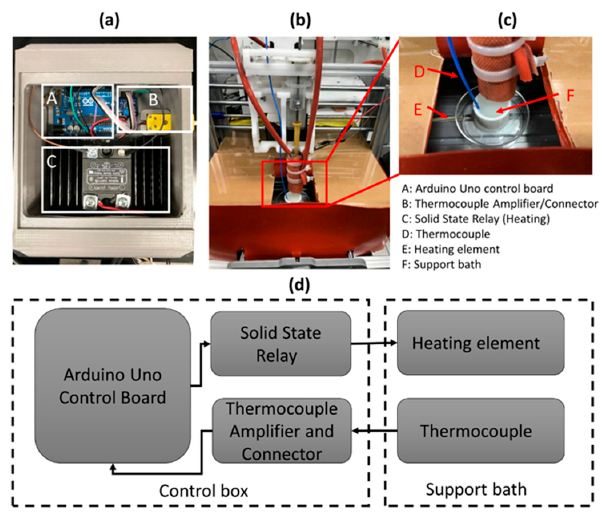
Figure 1. Temperature control system: ( a ) The control box; ( b ) the printing head; ( c ) configuration of thermocouple, heating element, and support bath; ( d ) the diagram of the temperature control system.